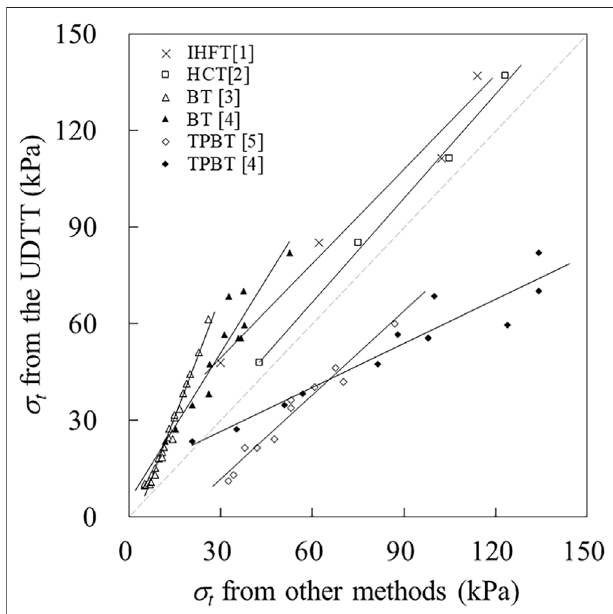
FIGURE 10 | Tensile strengths ( σ t ) obtained from the UDTT vs. those obtained from other test methods. Data sources: [1] Li et al., 2020, [2] Guan et al., 2022, [3] Wang 2011, [4] Li et al., 2007, and [5] Zhu